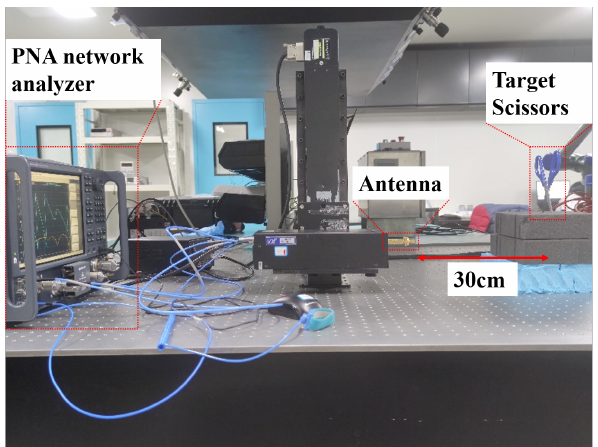
Figure 7. Experimental